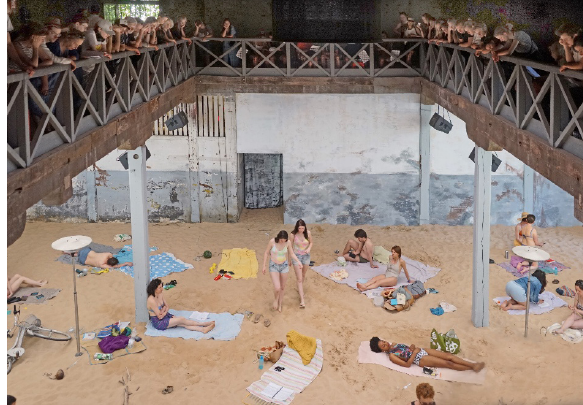
Figure 3. “Sun & Sea: Marina”, Lithuanian Pavilion,